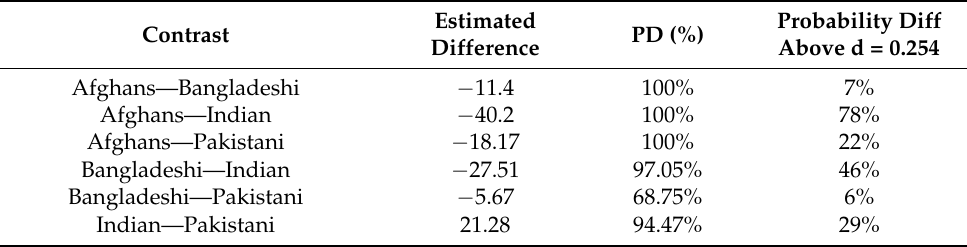
Table 3. Estimated differences of MVPA between ethnic